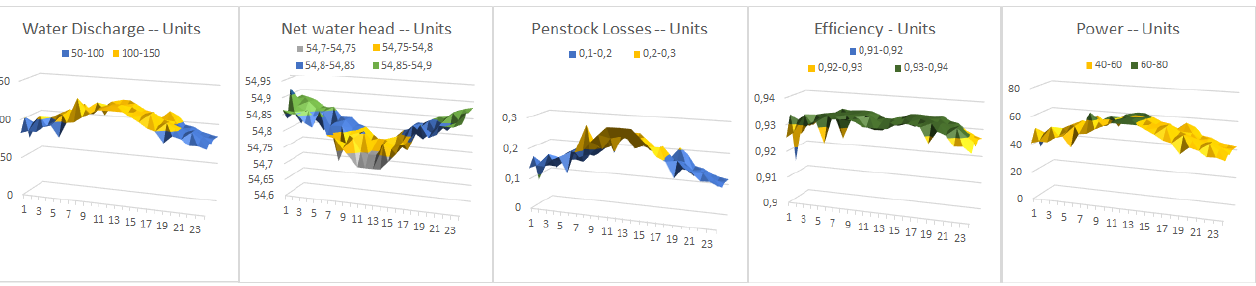
Figure 13. CRO with DE Mutation/Crossover (rand/1/bin)— CRO ( 3 r ) . Results of Water discharge (m 3 /s). Net water head (m). Penstock (m). Efficiency (%) and Power generated (MW/h). Daily dispatch (24